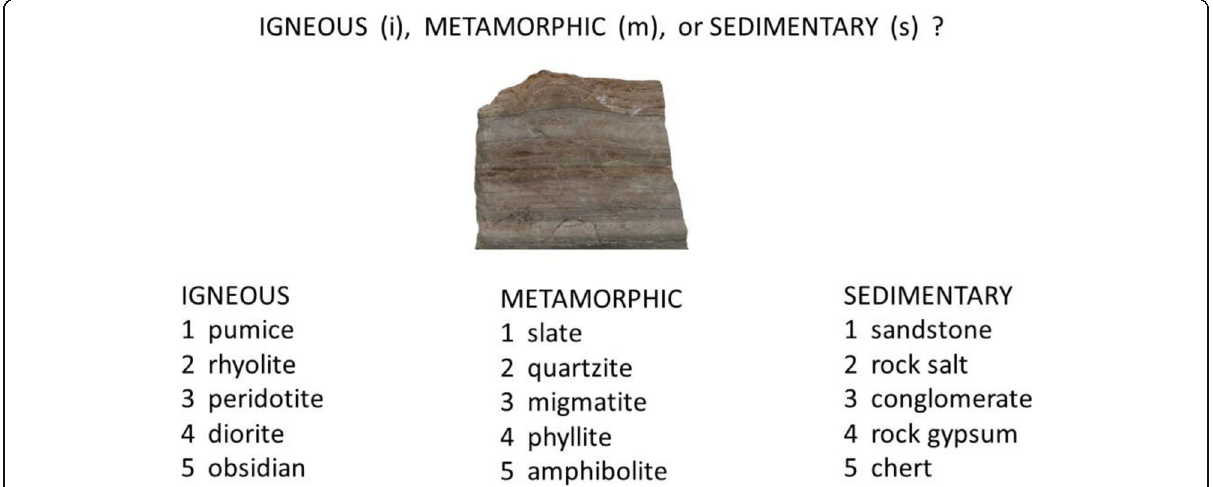
Fig. 3 Schematic example of the first stage of a typical trial from the training and test phases of condition 2 and the training phase of condition